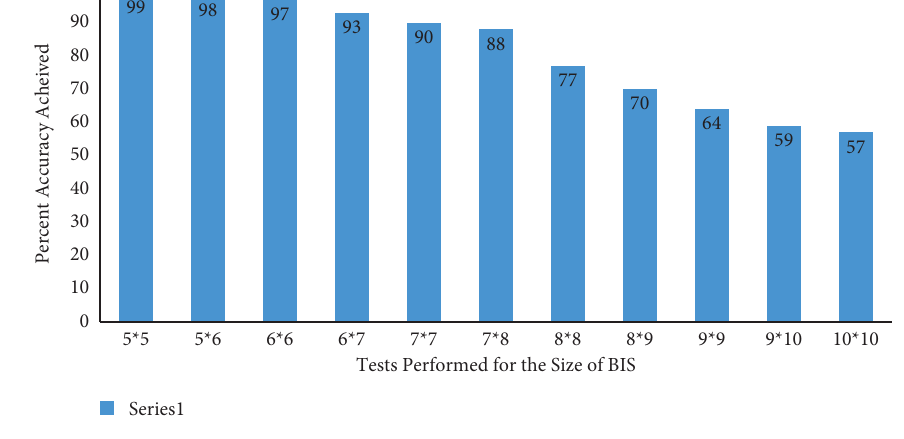
Figure 9: Percent accuracy for diferent BISs recalculated using BISGA.